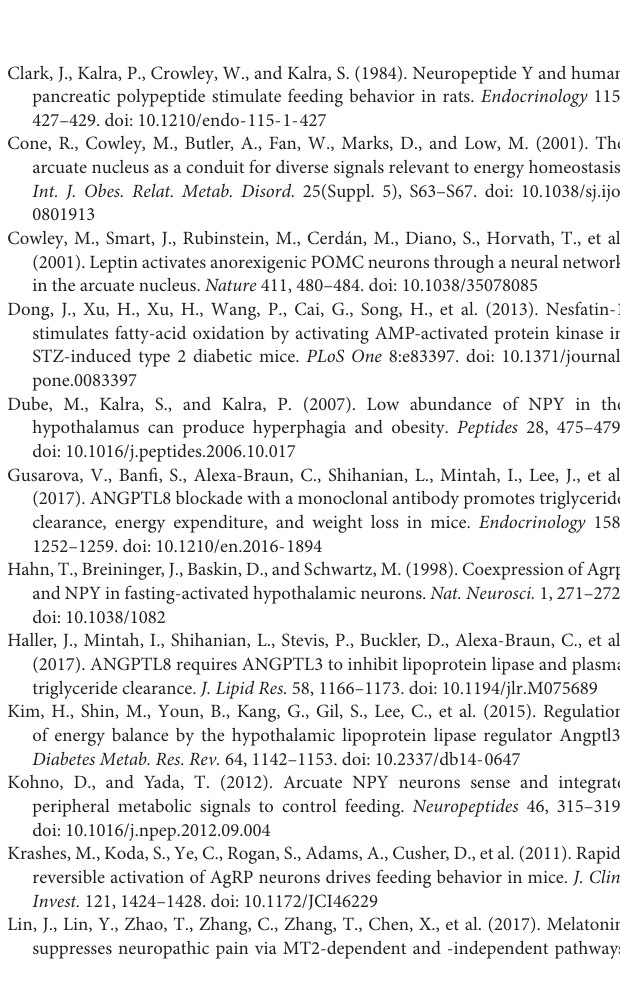
FIGURE S1 | The number of Angptl8 positive neurons in feeding and food deprivation state. Angptl8 was expressed in the hypothalamic DMH, PVN, VMH, and ARC in mice on chow diet and food deprivation for 12 h. ∗ P < 0.05 relative to the feeding